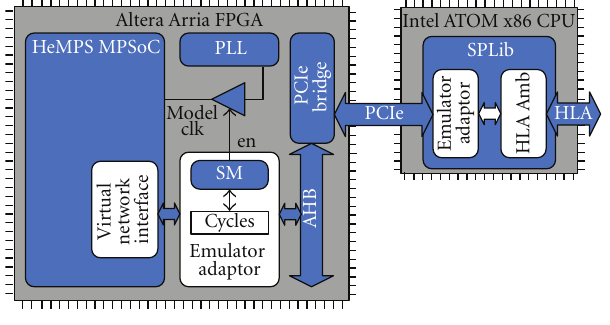
Figure 7: Emulator setup.